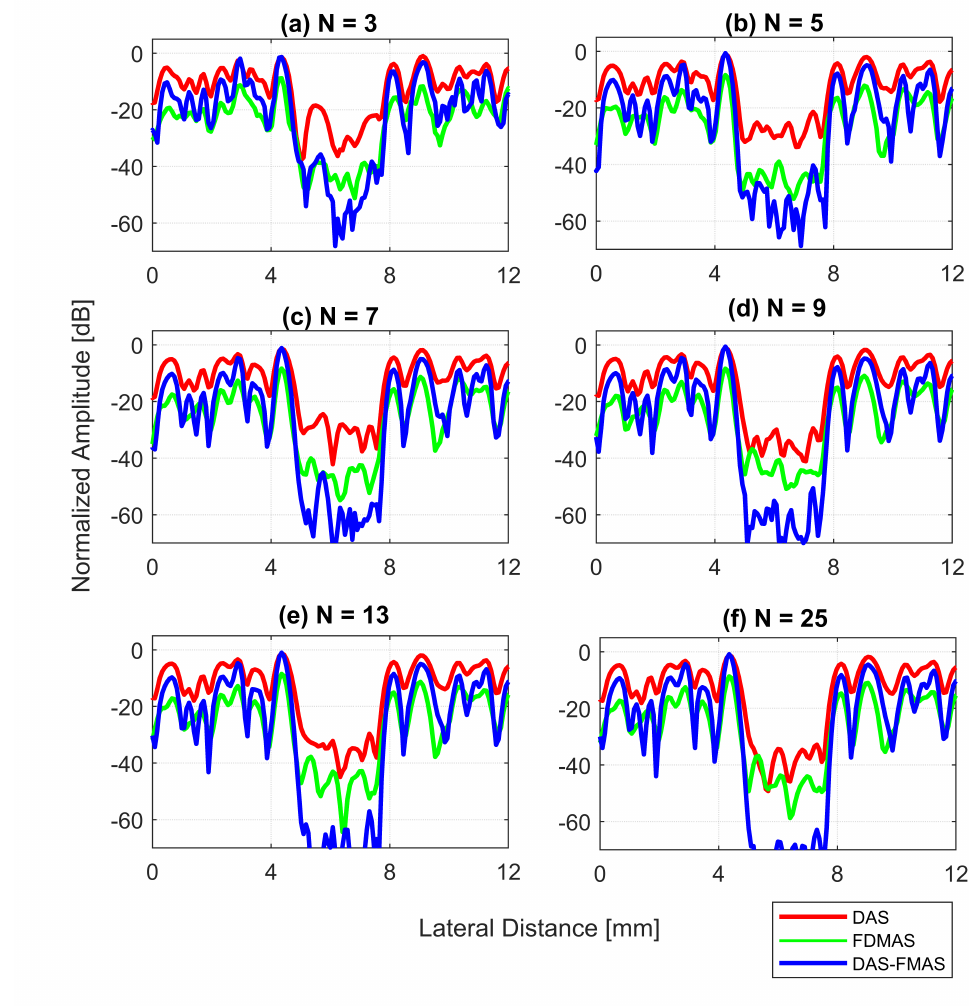
Figure 16. Lateral beam profiles for cysts with a diameter of 3.0 mm at a depth of 15 mm for ( a ) N = 3, ( b ) N = 5, ( c ) N = 7, ( d ) N = 9, ( e ) N = 13 and ( f ) N =